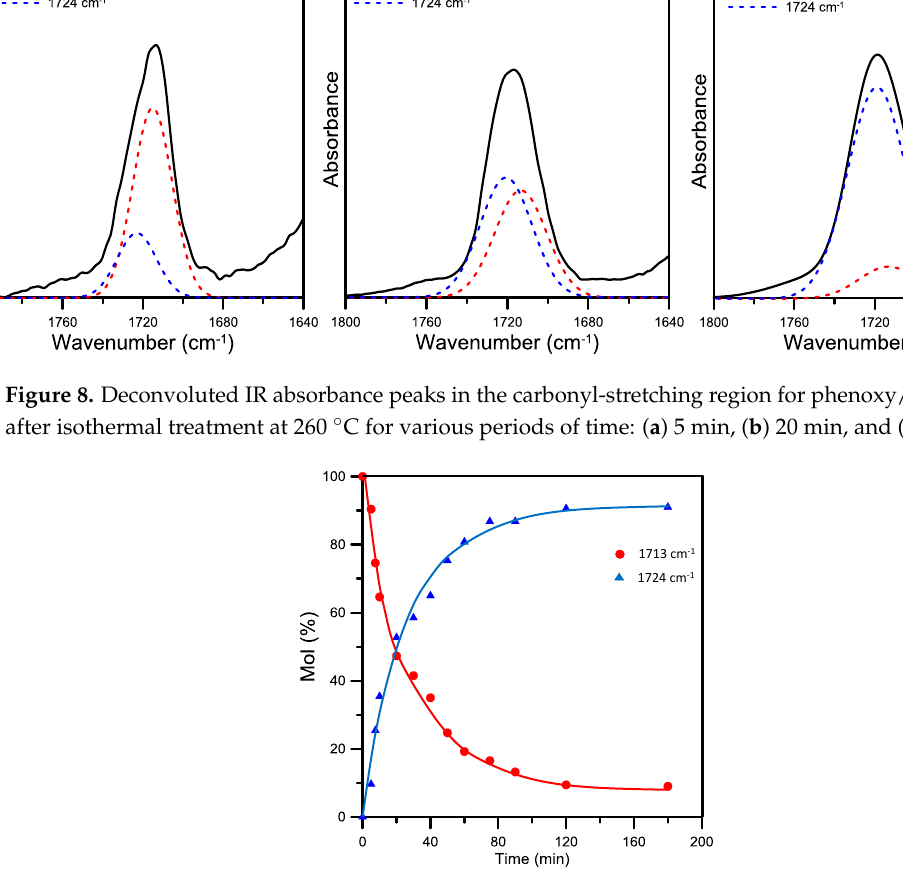
Figure 9. Mole fraction of specimens vs. heating time for phenoxy/PBT (9/1) at 260 °C.